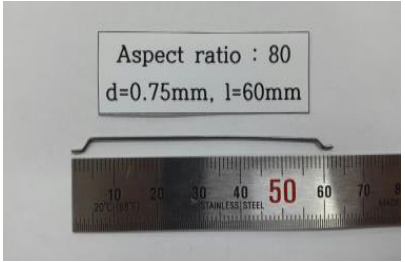
Figure 3. Shape of the used steel fibers.